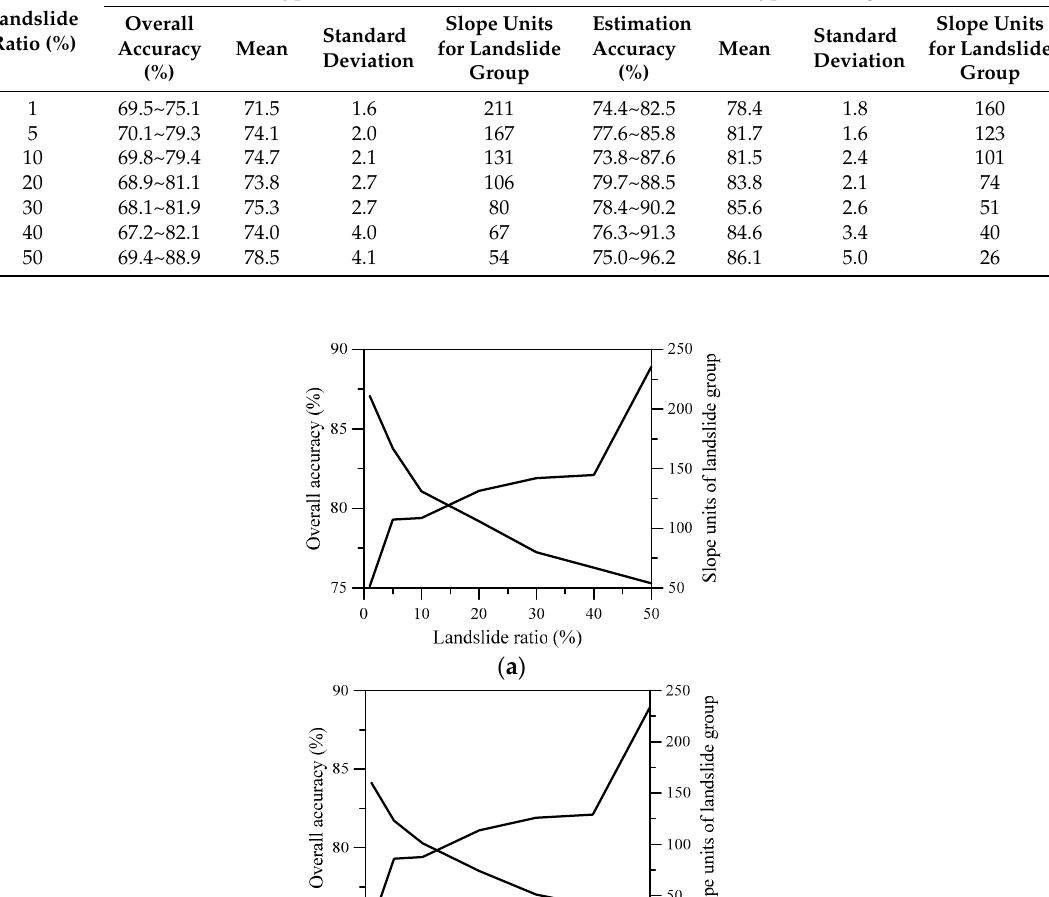
Landslide Ratio (%)